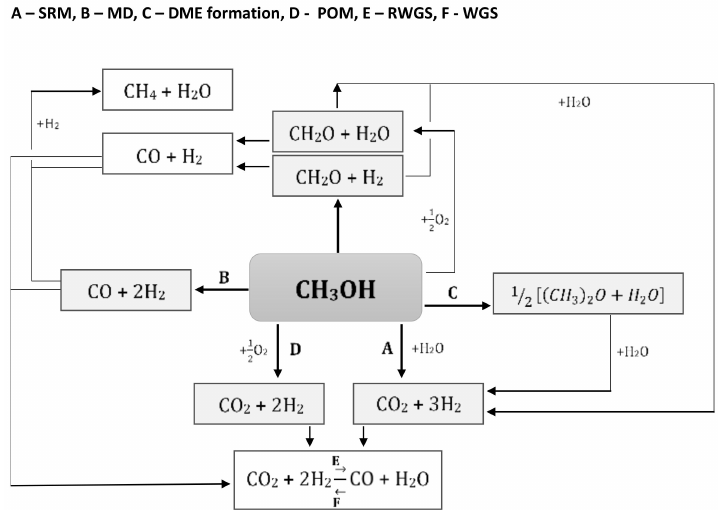
Figure 5. The reaction network taking place during oxidative steam-reforming of methanol (OSRM) process